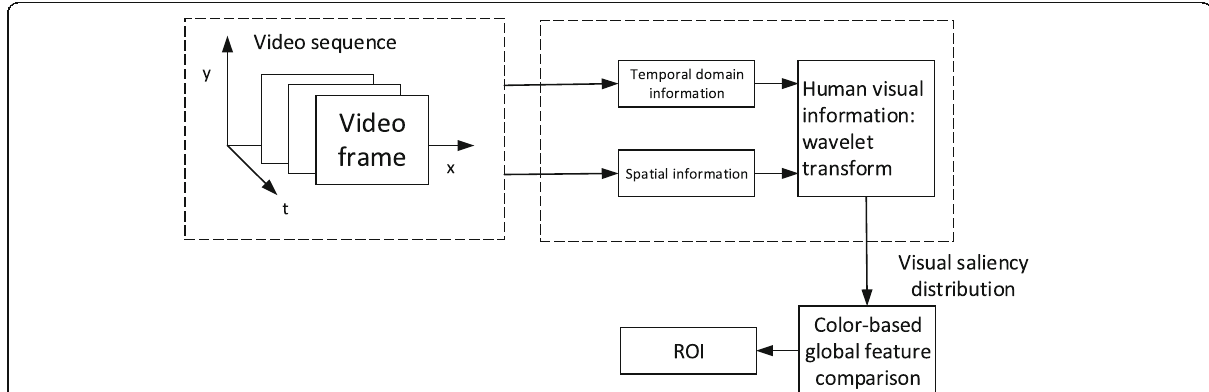
Fig. 3 A flowchart of visual information extraction model for video